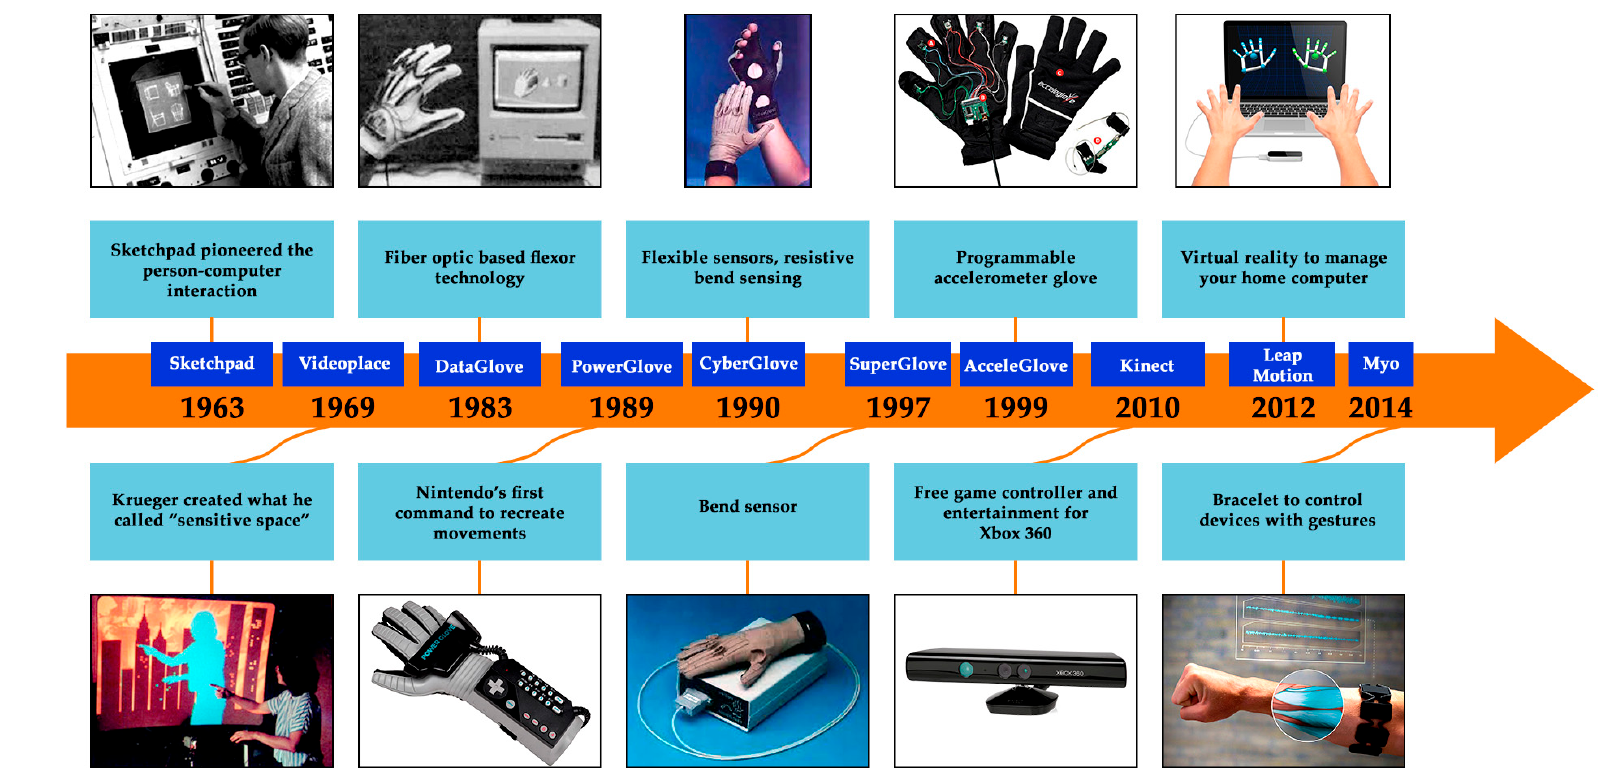
Figure A1. Timeline evolution of gesture recognition devices.